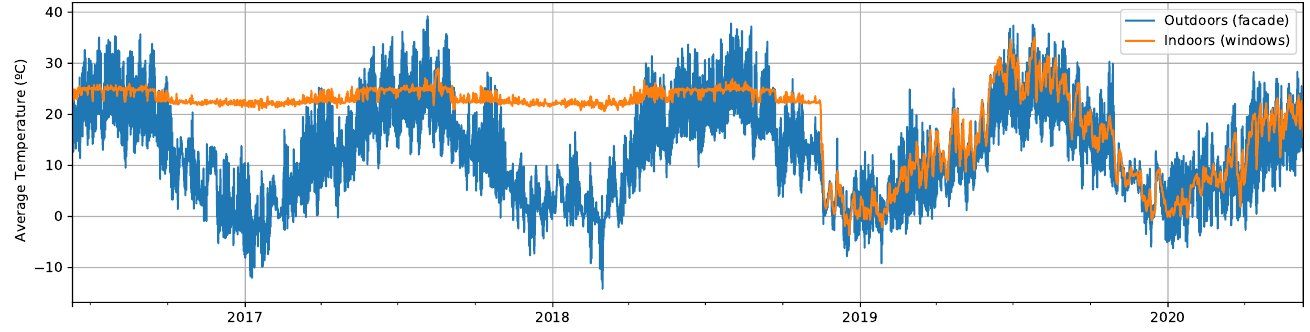
Figure 1. Average temperature (ºC) for the facade (blue) and windows (orange).